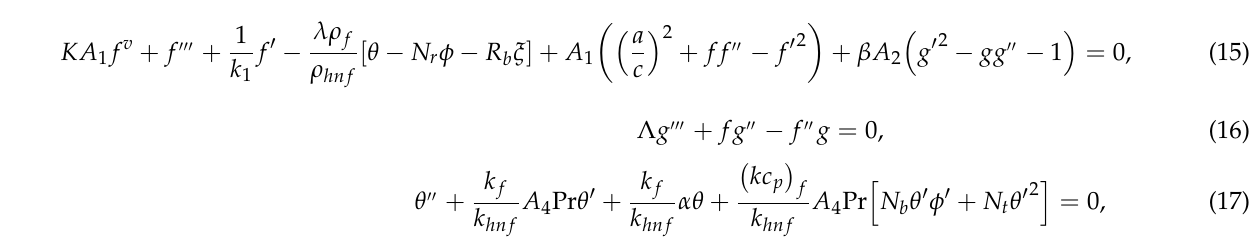
Figure 4. The effect of K on